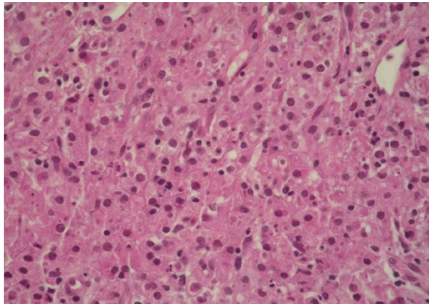
Figure 3: Immunohistochemically detected diffuse histiocytic infil- tration with anti-CD68 antibody (DAB ×